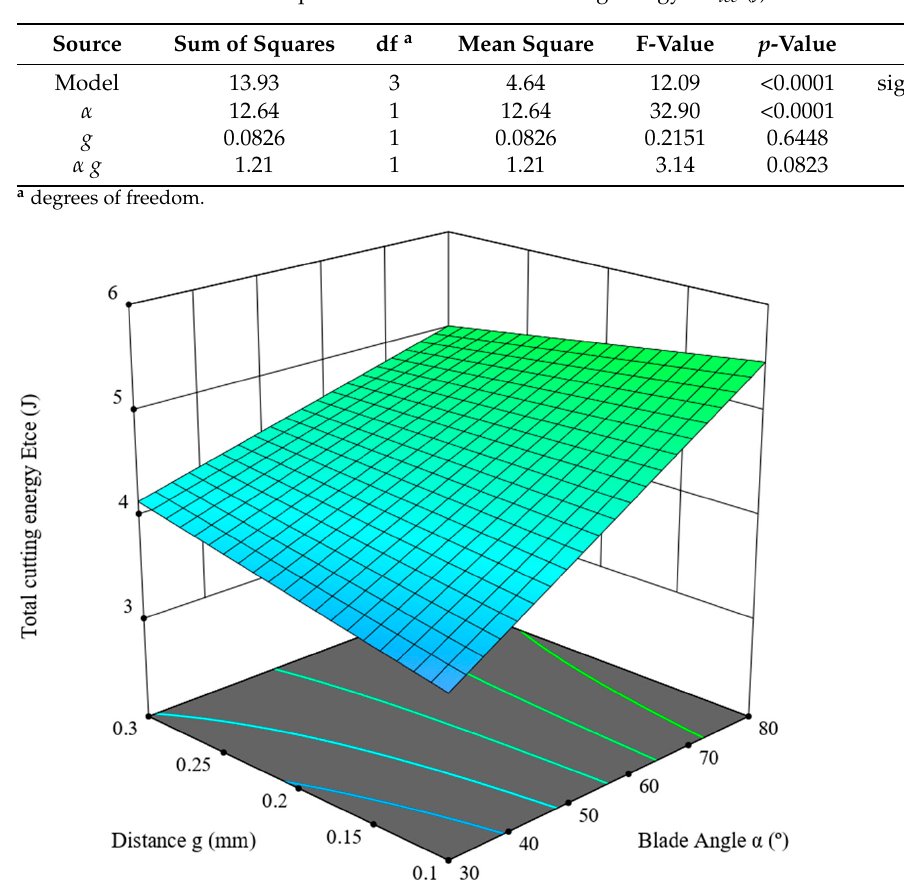
Table 5. ANOVA results. Dependent variable—total cutting energy —E tce (J).